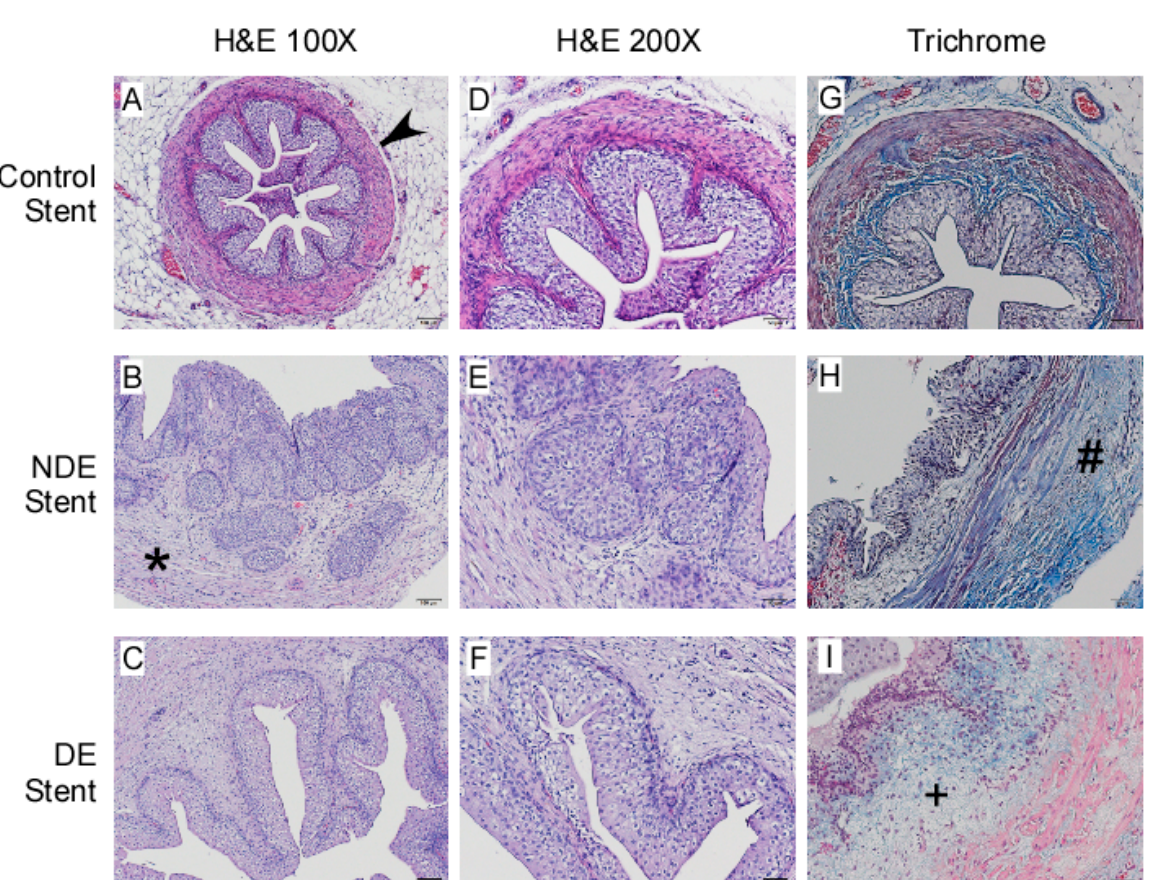
Figure 3. Photomicrographs showing hematoxylin and eosin ( A – F ), and Masson’s trichrome ( G – I ) staining of ureter cross-sections. ( A ). Histopathology changes of 100× magnification ( A – C ), 200× magnification ( D – F ), and Masson’s Trichrome stain at 200× magnification for collagen and smooth muscle distribution ( G – I ). ( A , B ) Circular smooth muscle decreased (arrowhead) when ureter fibrosis dominated (asterisk). ( H , I ) Collagen deposition was prominent in thermally injured ureters (hashtag) but was decreased in the drug-eluting group (plus).